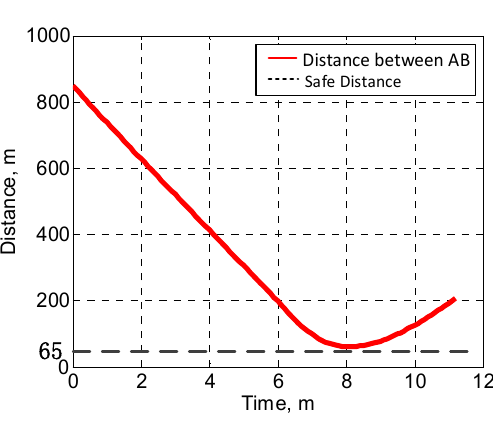
Table 6. Initial state.